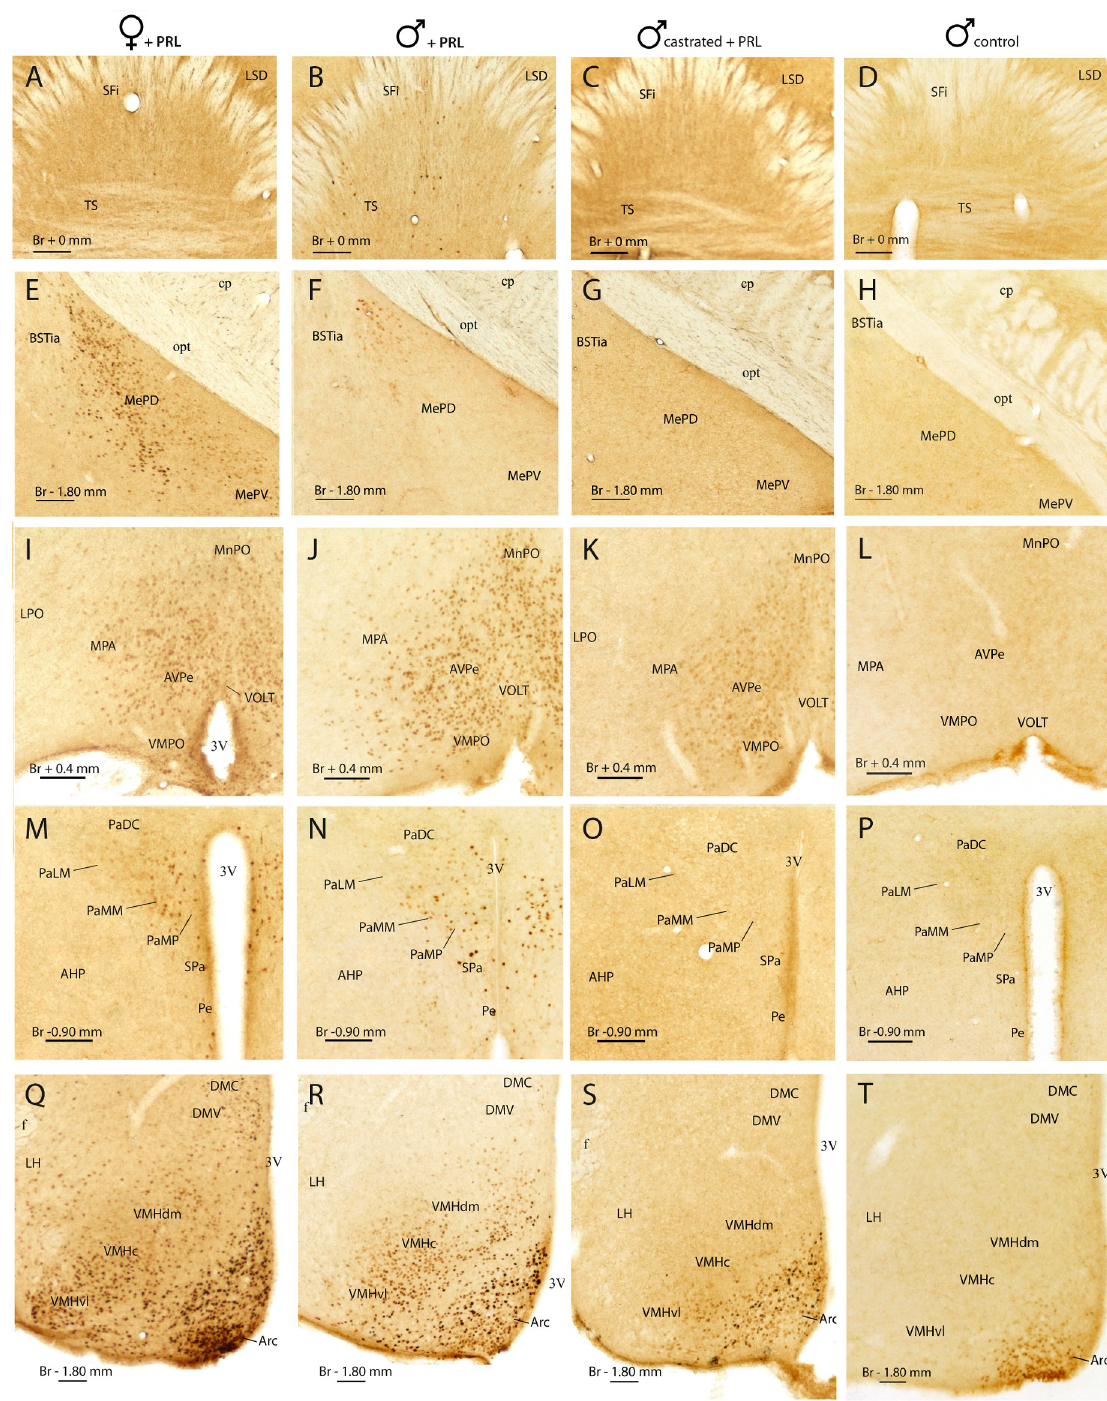
Fig 2. Representative examples of pSTAT5 immunoreactivity in the brain of females, intact males and castrated male mice. Photomicrographs illustrating pSTAT5 labelling in representative brain sections in an ovariectomized, steroid-primed female supplemented with PRL (leftmost column), an intact, PRL-supplemented male (left-center column), a castrated, PRL supplemented male (right-center column) and a intact control male lacking PRL supplementation (rightmost column). Sections correspond to the caudal septum (A-D), the posterior medial amygdaloid region (E-H), the preoptic hypothalamus (I-L), the paraventricular hypothalamic region (M-P) and the tuberal hypothalamus (Q-T). The approximate distance to bregma is indicated in each section. Scale bars correspond to 100 μ